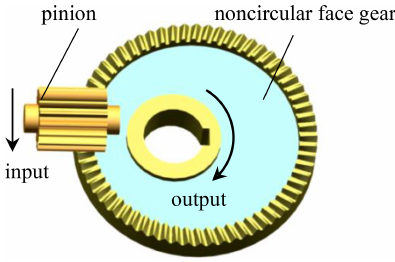
Figure 1. Noncircular face gear